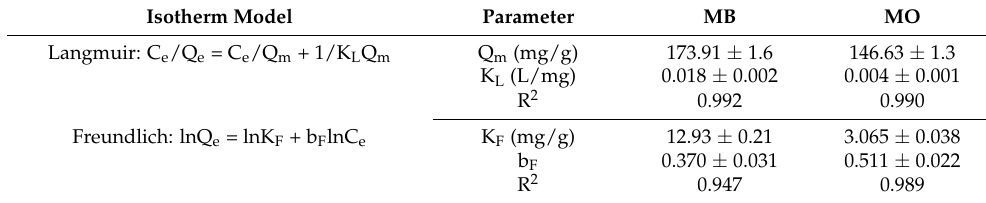
Table 3. The isotherm parameters for the adsorption of MB and MO onto the mPVA/AC CG.